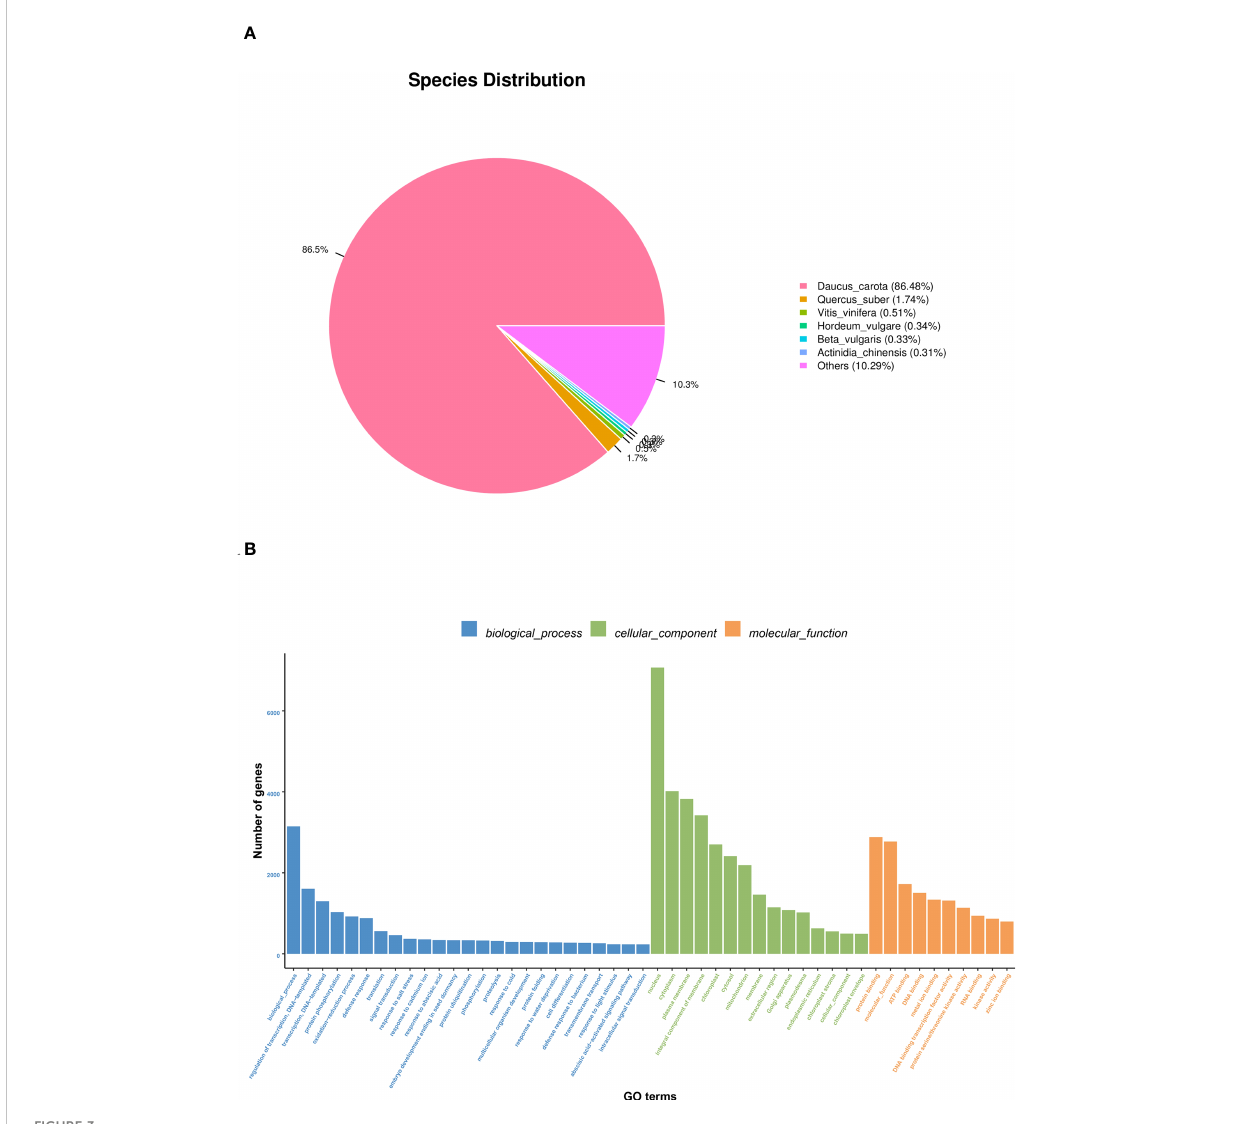
FIGURE 3 Distribution of NR homologous species (A) and the result of GO function annotation (B)